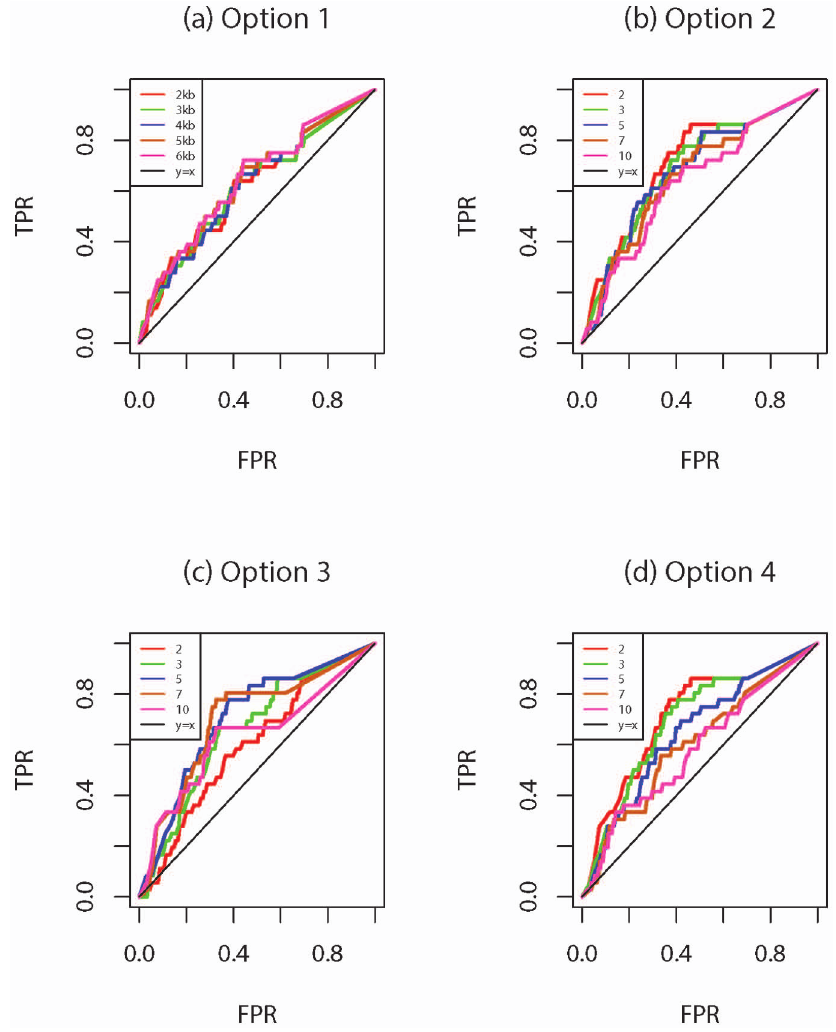
Figure 1. rbPDT results using different blocking options: (a) Option 1 with block size 2, 3, 4, 5, or 6 kb; (b) Option 2 with number of blocks 2, 3, 5, 7, or 10; (c) Option 3 with blocks including 2, 3, 5, 7, or 10 SNVs; (d) Option 4 with number of blocks 2, 3, 5, 7, or 10.